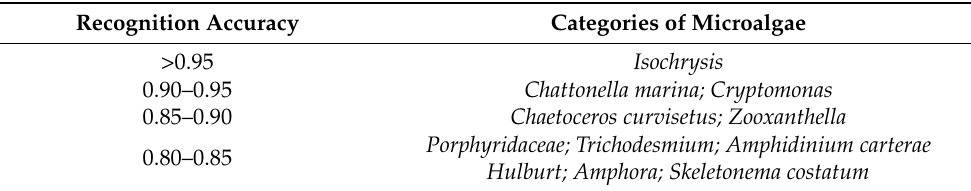
Table 3. Classification results using SVM by one-versus-rest